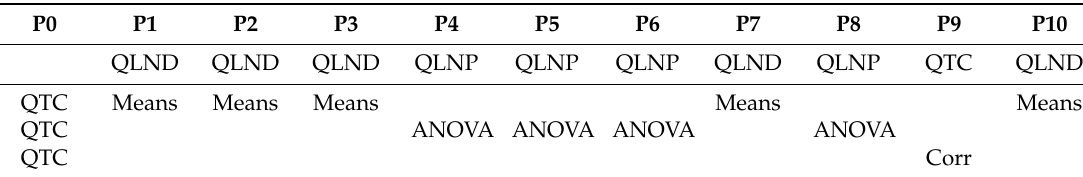
Table 1: Statistical method in Time mode. Table 2: Statistical method in Frequency mode. Table 1. Statistical method time mode.